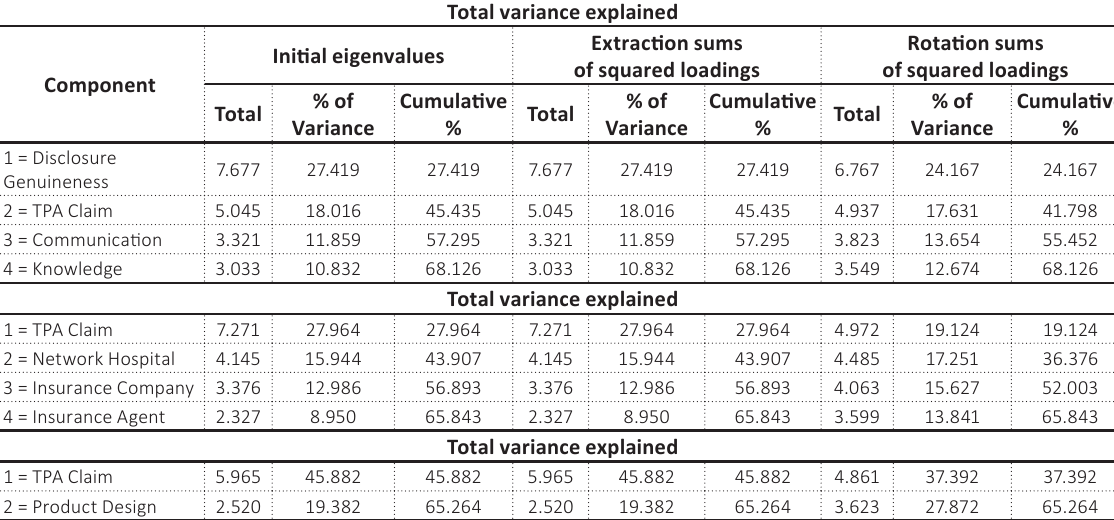
Table 3. Variance